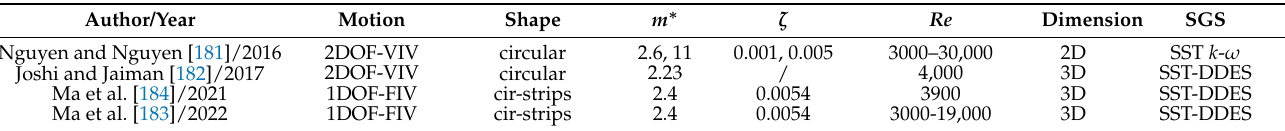
Table 5. Summary of some key DES studies of the flow-induced vibration of bluff